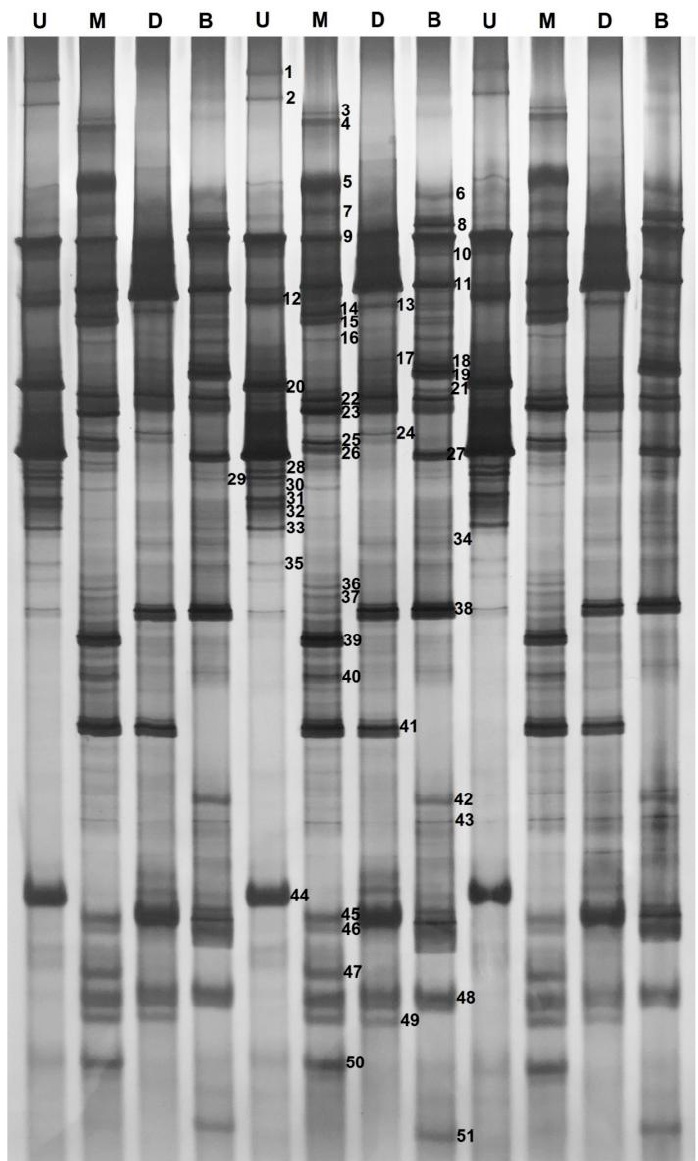
Figure 2. PCR-DGGE fingerprints of ITS gene extracted from the fungal community in the pit mud samples collected from different spatial positions of the cellar. Lanes U, M, D, and B represent samples collected from the up wall layer of the cellar, middle wall layer of the cellar, down wall layer of the cellar, and bottom layer of the cellar, respectively. The bands indicated with numbers were excised and sequenced and the alignment results are listed in Table 2. Table 1. Indices of fungal diversity in the samples collected from different spatial positions of the cellar according to quantified bands from Figure 2.